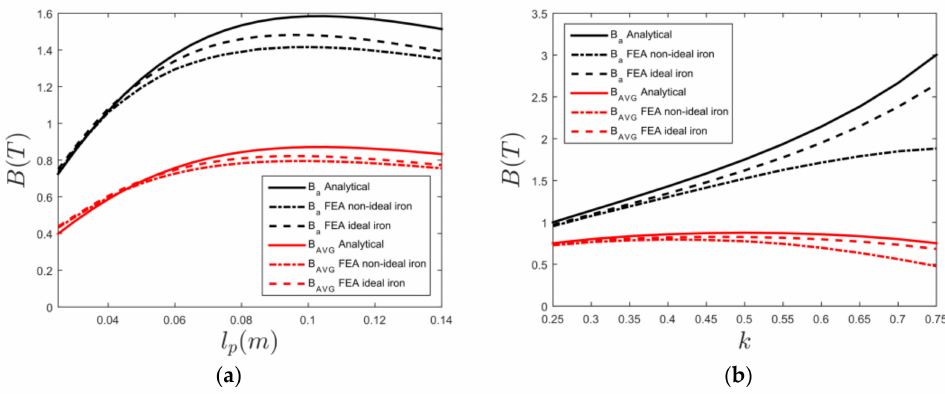
Figure 2. The dependence on pole length ( a ) and k ( b ) for the magnetic flux density in the airgap in direct position in black and the average airgap flux density in red is shown for a linear generator with parameters δ = 0.003 m, w T = 0.2 m, and δ r,m = 1.1. In ( a ), k = 0.45 and in ( b ), l p = 0.103 m. Values from analytical calculations, 2D Finite Element Analysis (FEA) simulations with ideal iron and 2D FEA simulations with an iron with saturation effects are shown.